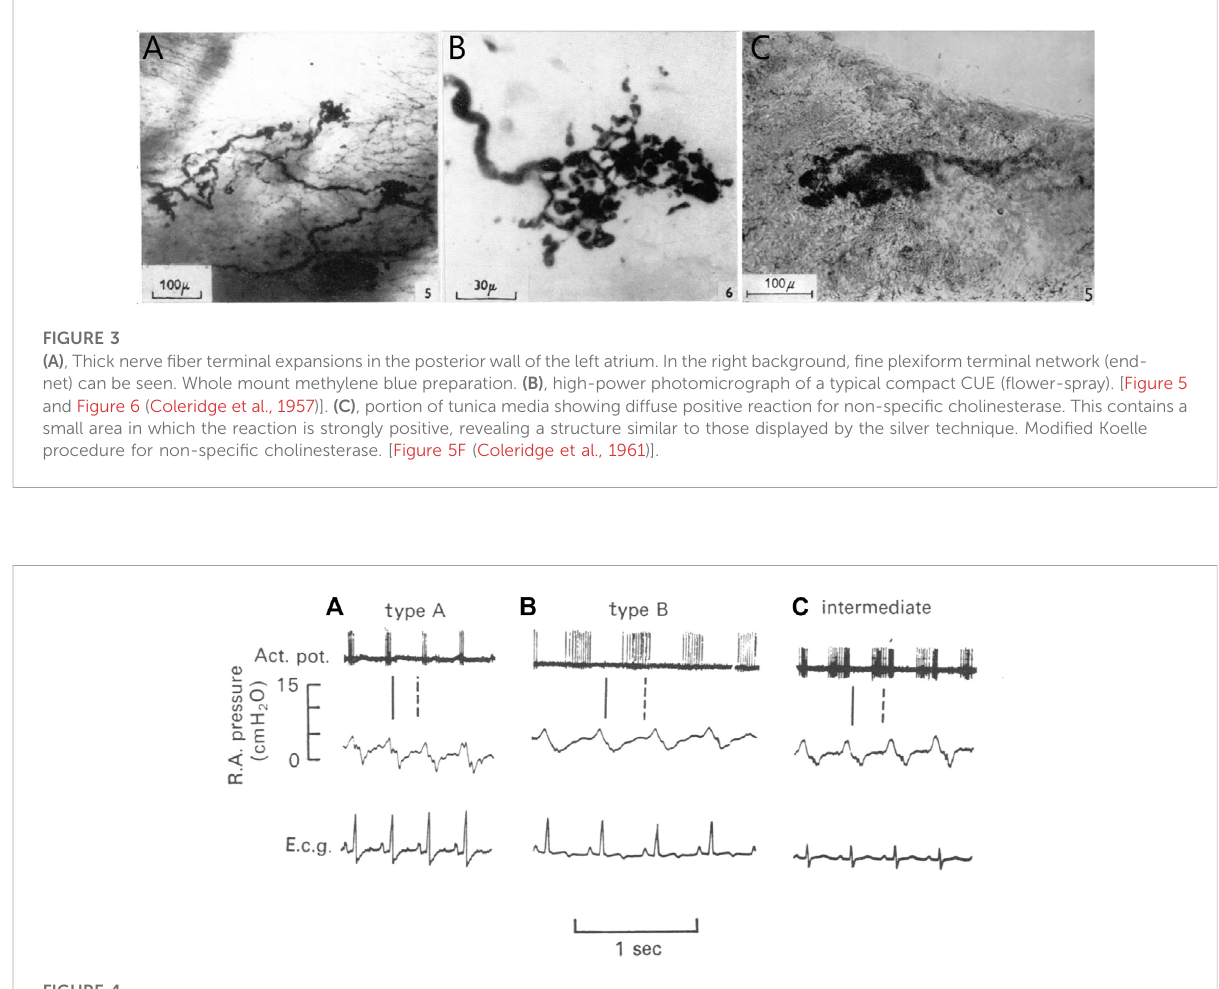
FIGURE 4 Illustration of three types of atrial units in the dog. (A) , type A unit. (B) , type B unit. (C) , an intermediate unit. Top, action potentials; Middle, right atrial pressure; and Bottom, electrocardiogram (e.c.g.). The vertical lines denote the temporal relationship between action potentials and the atrial pressure waves. The continuous line is the end of the “ a ” wave and the interrupted line is the peak of the “ v ” wave (Kappagoda et al.,